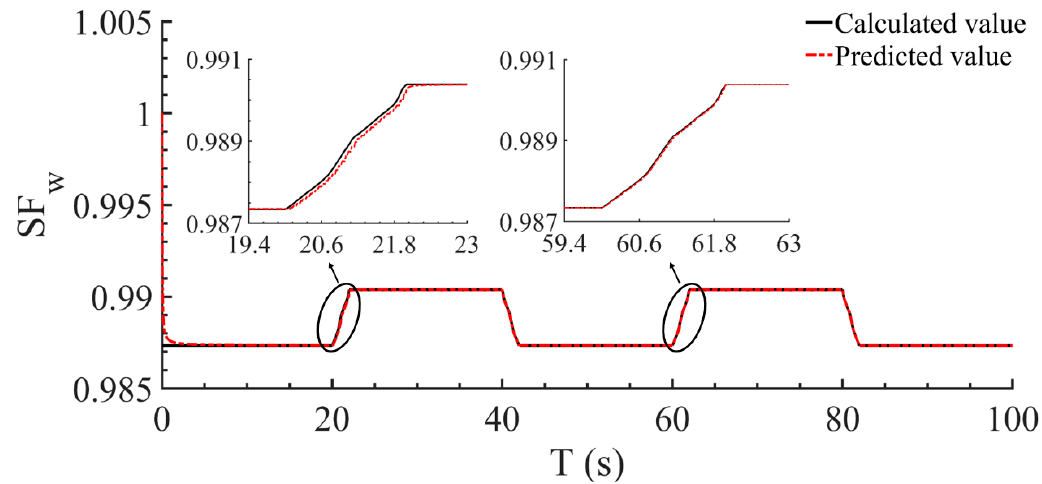
SF ω . Figure 15. Prediction results of the SF , HPC ω , HPC